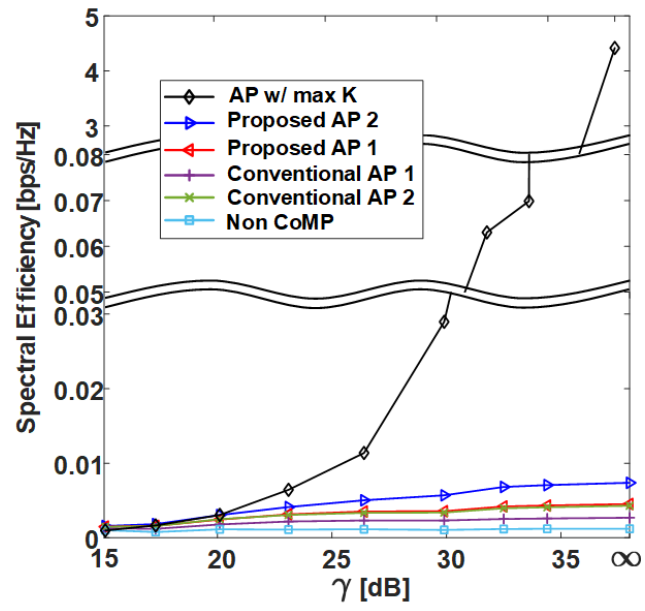
Figure 12. Spectral efficiency at 5% outage level of various clustering schemes with respect to γ in uniform